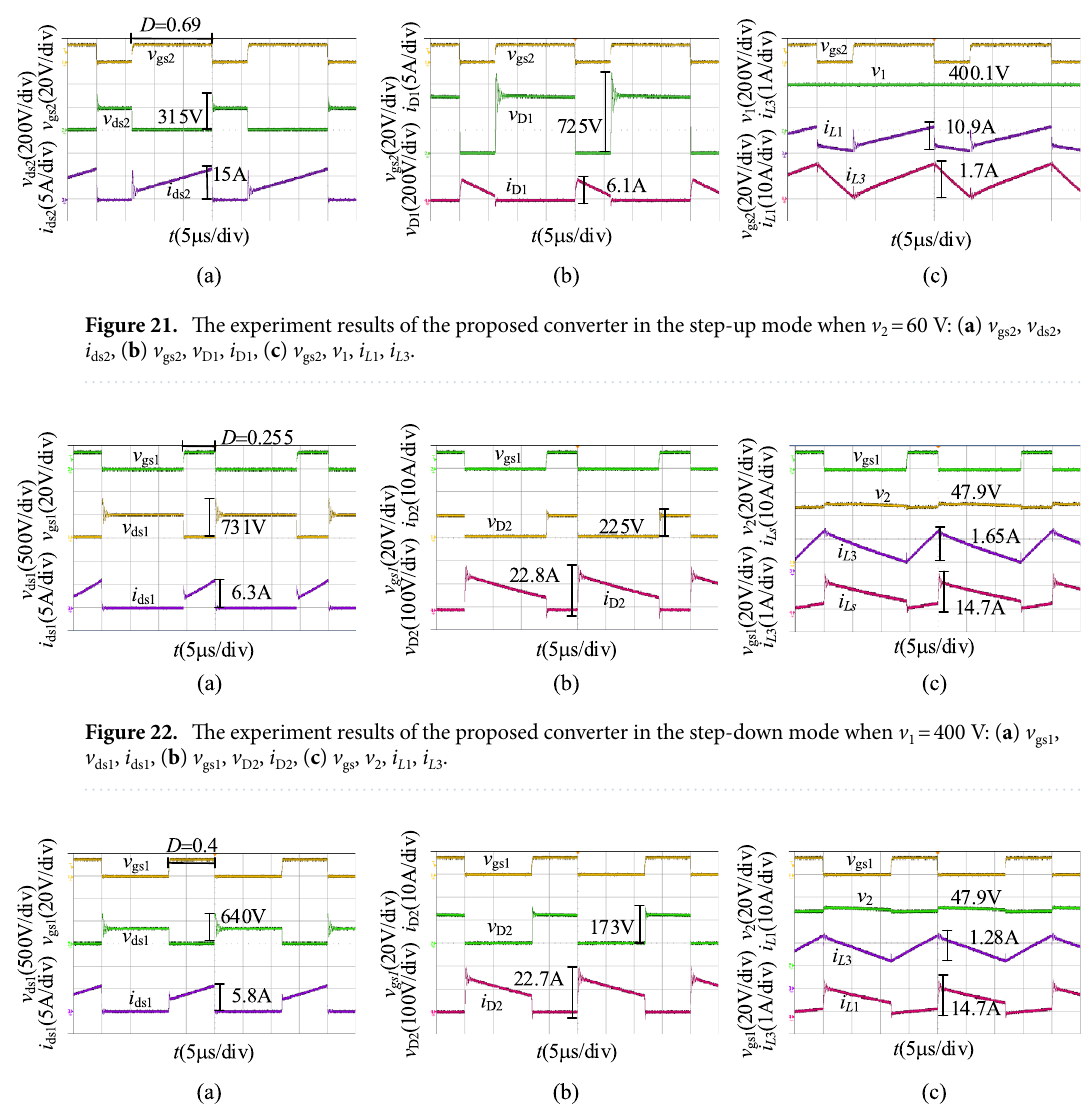
Figure 23. The experiment results of the proposed converter in the step-down mode when v 1 = 250 V: ( a ) v gs1 , v